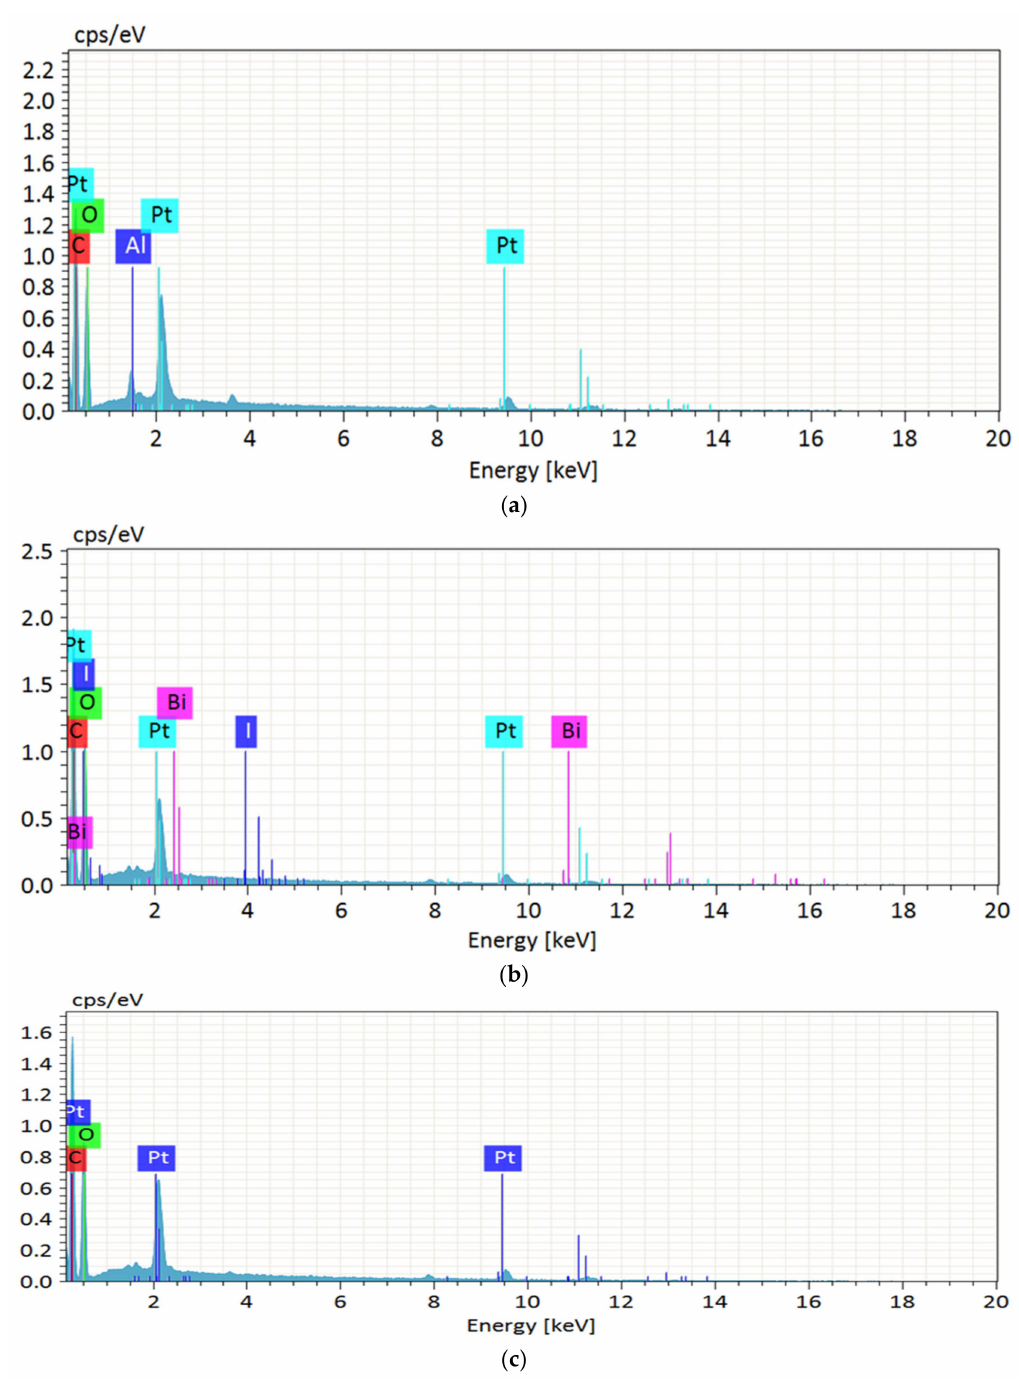
Figure 2. EDX spectra of ( a ) WAKL, ( b ) WBLH, and ( c ) WMCC